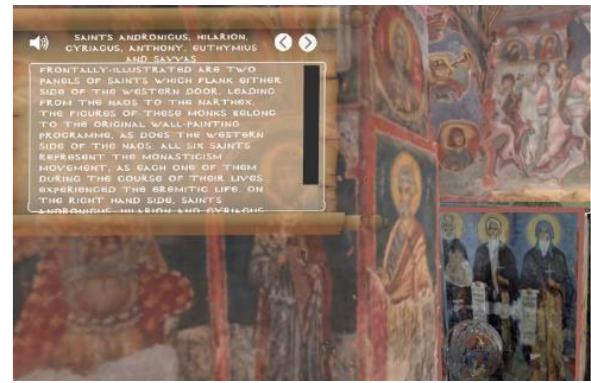
Figure 13. Tour guide through the frescoes with all the storytelling about the the12th-century Byzantine paintings.